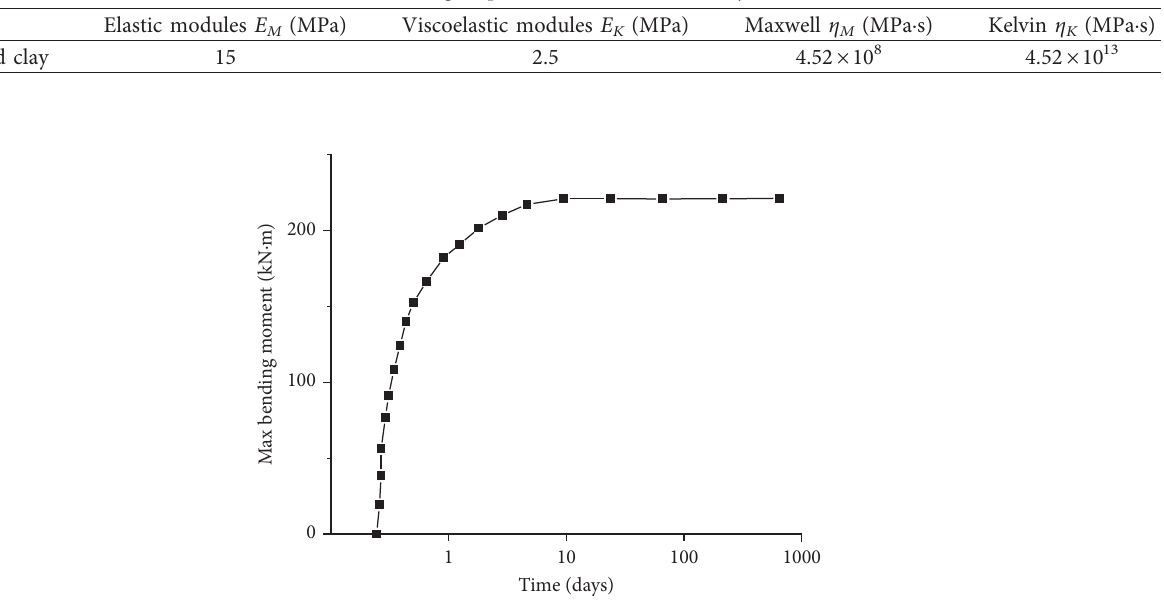
Figure 20: The maximum bending moment over time.